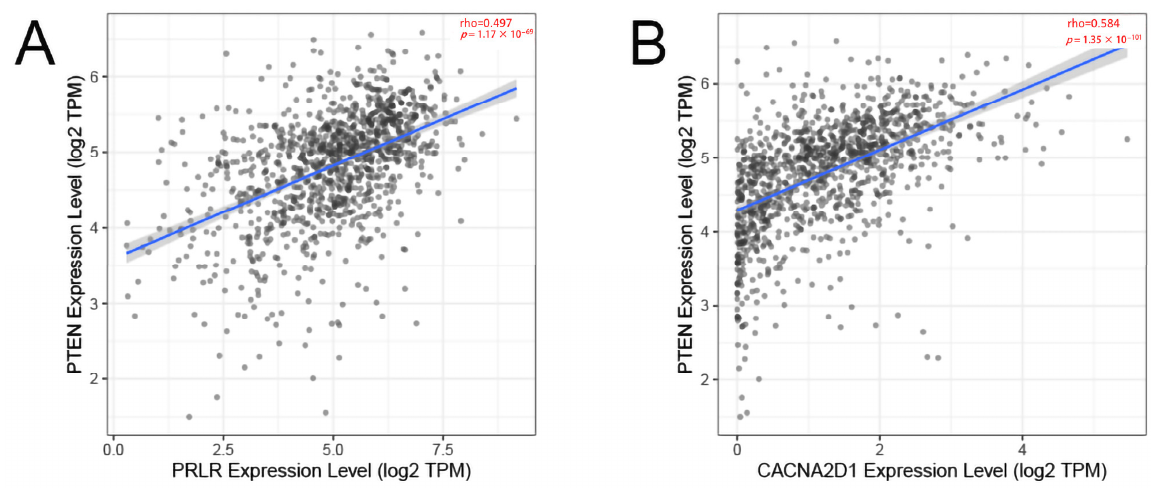
Figure 6. The correlation between PRLR and PTEN ( A ) and the correlation between CACNA2D1 and PTEN ( B ).